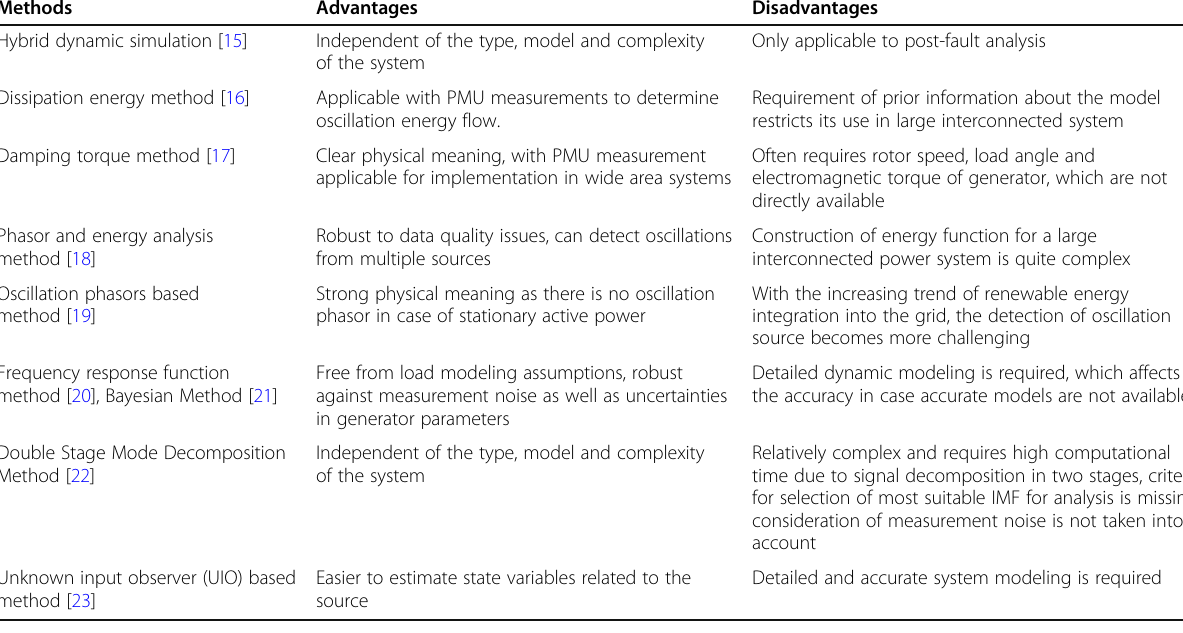
Table 1 Summary of performance of various methods available in the literature